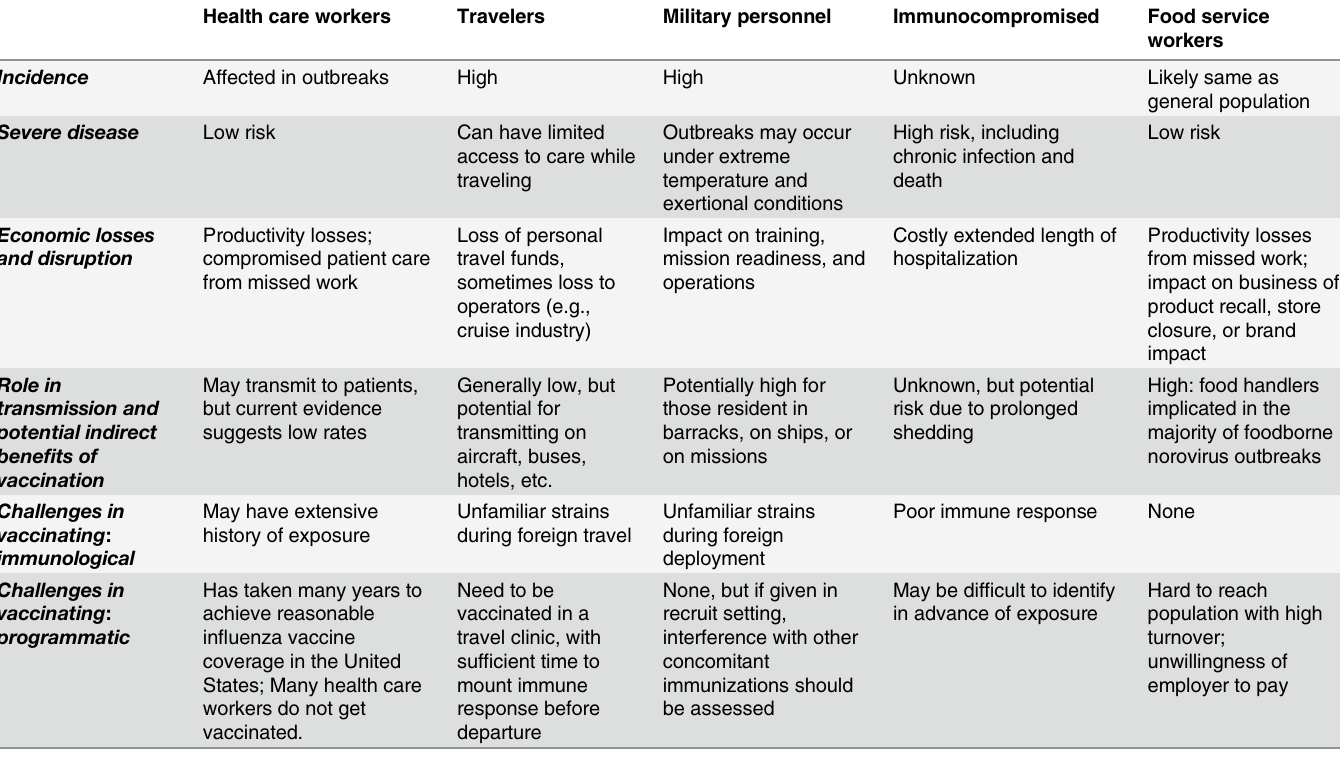
Table 2. Epidemiological, economic, and programmatic considerations for specific subpopulation risk